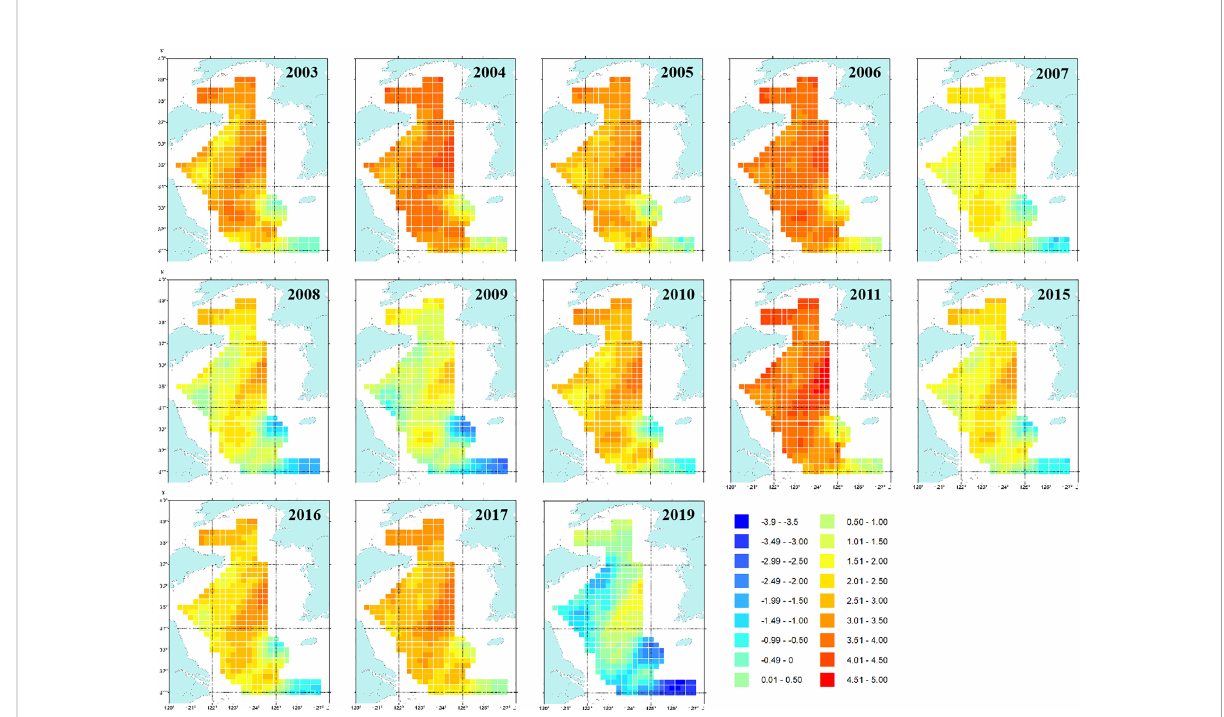
FIGURE 3 Maps showing spatial patterns of log-density by the AIC-selected spatio-temporal model (M2) for snail fi sh in the Yellow Sea in 2003 – 2019. The units of the color legend is ln(kg/km 2 ). It is noted that only estimations for those years where biomass trawl survey data (i.e., 2003 – 2011, 2015 – 2017 and 2019) available for snail fi sh were